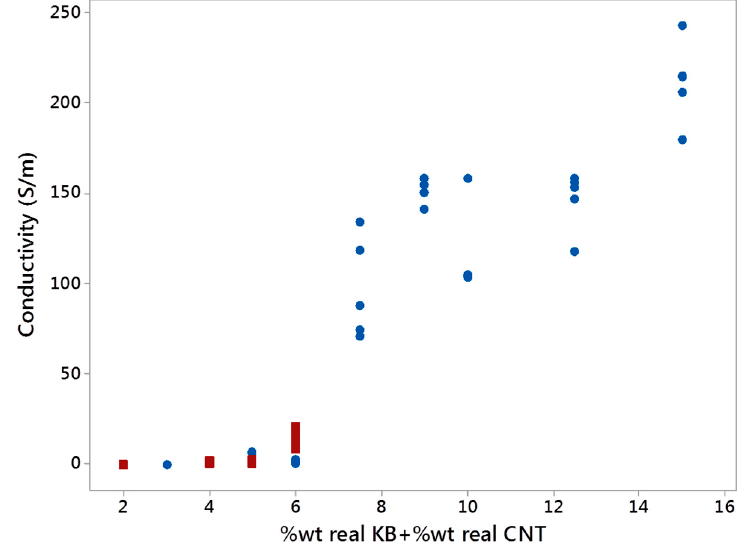
Figure 15. Electrical conductivity (S/m) as a function of the real KB and CNT percentages in the biphasic blends with a dominance of LDPE (in blue) and dominance of PBE (in red).